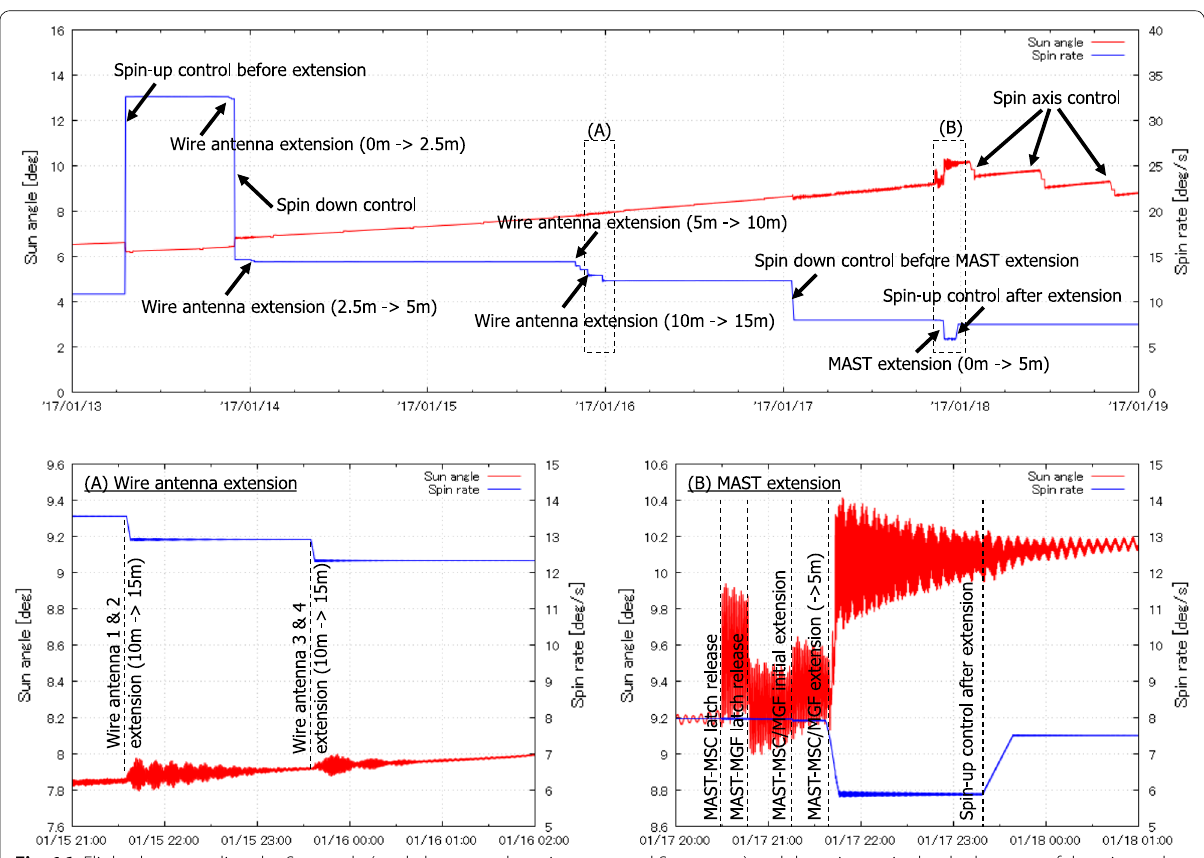
Fig. 16 Flight data regarding the Sun angle (angle between the spin vector and Sun vector) and the spin rate in the deployment of the wire probe antennas and masts. a and b The Sun angle, and therefore the nutation angle of the satellite, is higher during deployment operations and slowly returns to a lower value